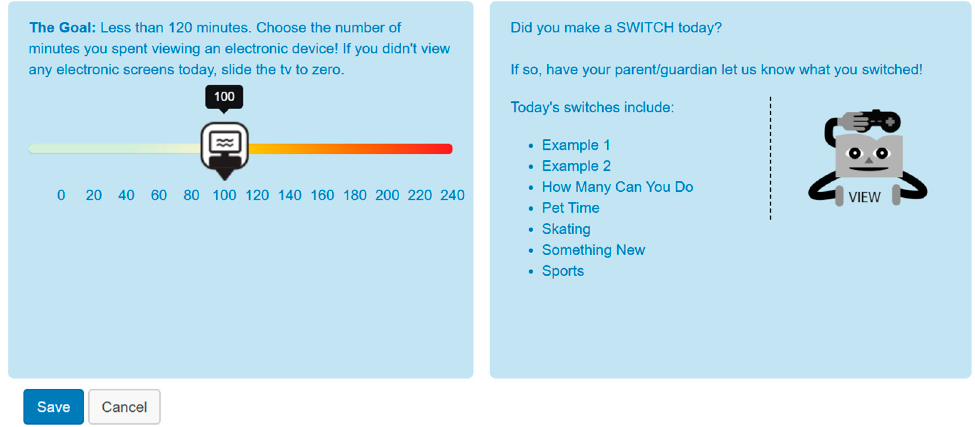
Figure 1. School Wellness Integration Targeting Child Health (SWITCH ® ) website self-monitoring interface.